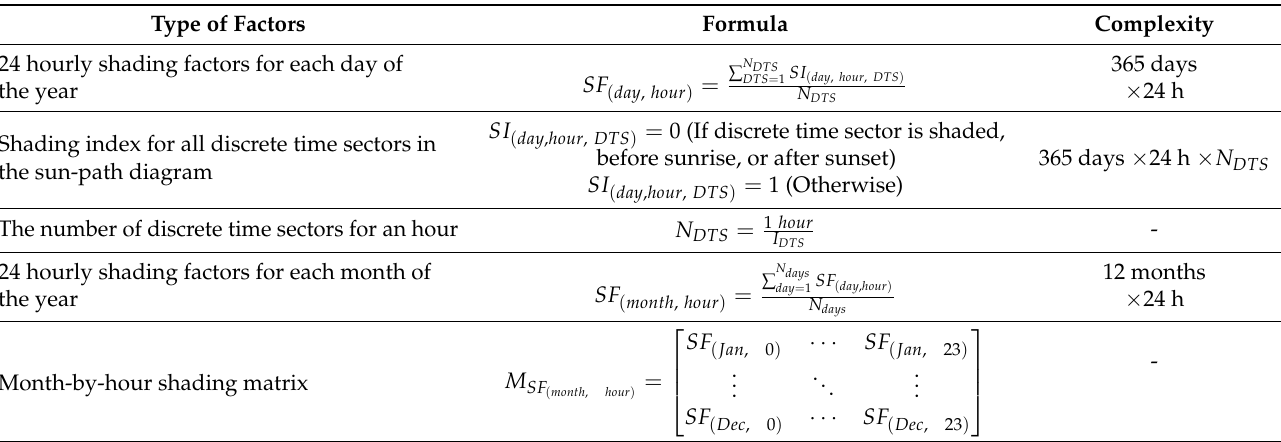
Figure 5. Sun-path diagrams overlaid on skymaps generated using ( a ) 3D model and ( b ) fisheye image. Table 2. Description of factors used for shading matrix calculation.